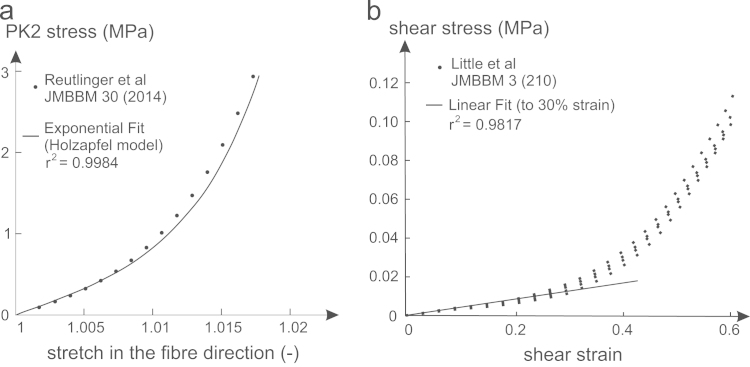
(a) Exponential fit to the model from Reutlinger et al. (2014) used to calibrate k1 and k2, and (b) linear fit to the shear data from Little et al. (2010) used to calibrate G.